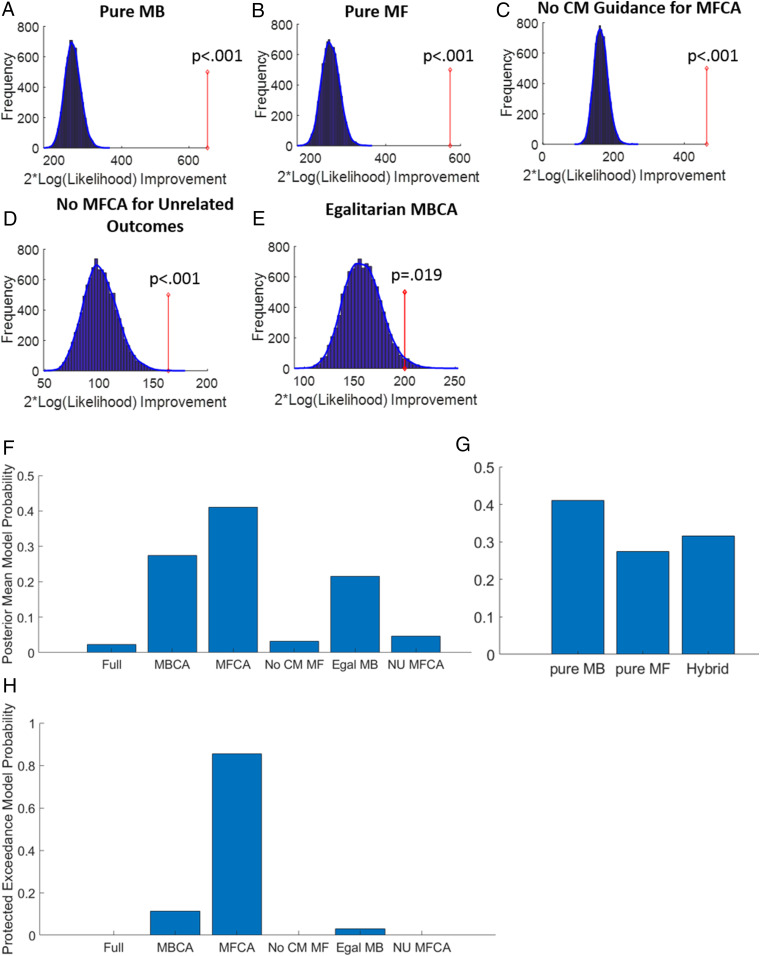
Model-comparison results. (A) Results of the bootstrap-GLRT model comparison for the pure MBCA submodel. The blue bars show the histogram of the group twice log-likelihood improvement (model versus submodel) for synthetic data simulated using the submodel (10,000 simulations). The blue line displays the smoothed null distribution (using MATLAB’s “ksdensity”). The red line shows the empirical group twice log-likelihood improvement. A total of 0 out of the 10,000 simulations yielded an improvement in likelihood that was at least as large as the empirical improvement. Thus, the submodel can be rejected with P < 0.001. (B–E) Same as A but for the pure MFCA (P < 0.001), the no CM guidance for MFCA (P < 0.001), the no MFCA for choice-unrelated outcome (P < 0.001), and the egalitarian MBCA (P = 0.019) submodels. (F) The posterior expected probabilities of the different models in the population, obtained using on hierarchical Bayesian model selection method. “Full”: Full model. MBCA/MFCA: pure MBCA. MFCA submodels: No CM. MF: no CM guidance for MFCA submodel. Egal MB: Egalitarian MBCA submodel. NU MFCA: No MFCA for unrelated-choice outcomes submodel. (G) Posterior expected model probabilities in the population when pooling together the various Hybrid models (Full; NO CM MF; Egal MB; and NU MFCA). (H) Protected exceedance probabilities for the various models.